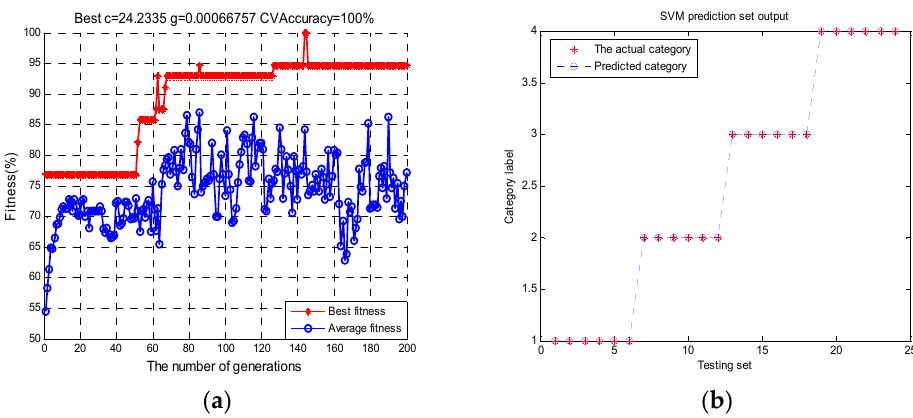
Figure 2. Classification process for liquor taste information with GA-SVM: ( a ) The parameter optimization fitness curve. ( b ) The classification result.